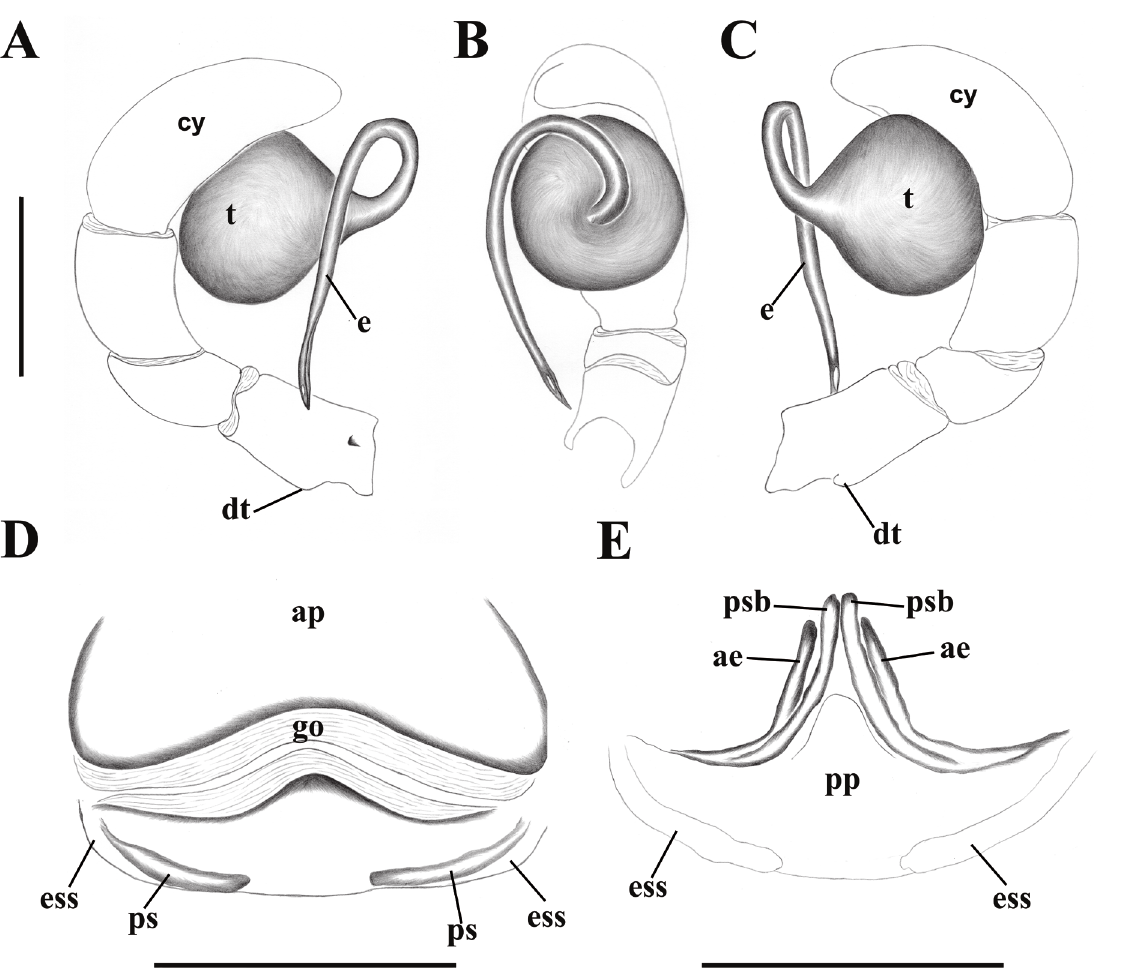
Fig. 2. Caponina alejandroi sp. nov. A – C . ♂, holotype (IAvH-I 3747). D – E . ♀, paratype (IAvH-I 3749). A . Left palp, retrolateral view. B . Left palp, ventral view. C . Left palp, prolateral view. D . External genitalia, ventral view. E . Internal genitalia, dorsal view. Scale bars: A–D = 1.5 mm; E–G = 1 mm; H–I = 0.5 mm. Abbreviations: see Material and